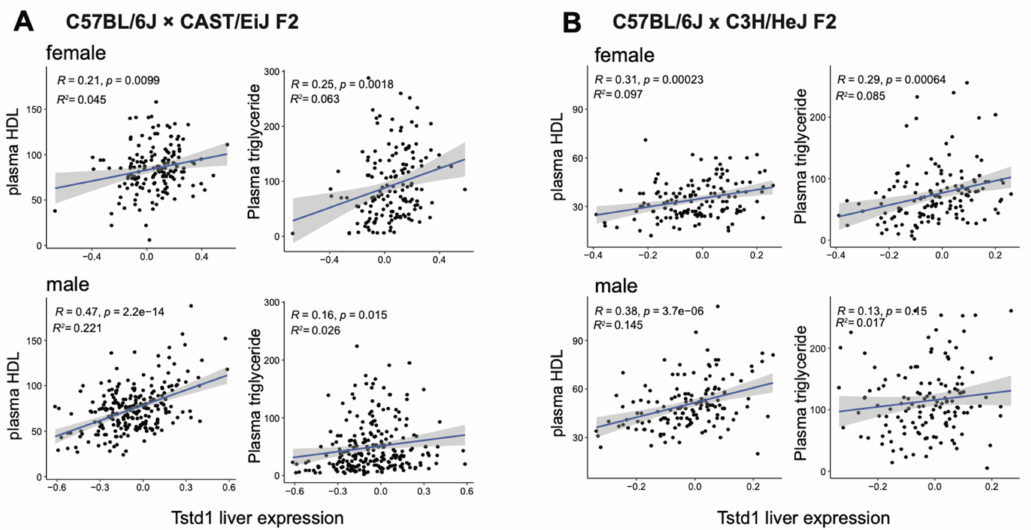
Figure 5. Validation of the link between Tstd1 and HDLs using independent mouse cohorts. Correlations between liver Tstd1 expression and plasma HDL and triglyceride levels were investigated in male and female mice from the F2 cohorts derived from C57BL/6J and CAST/EiJ ( A ) and C57BL/6J and C3H/HeJ ( B ) Pearson’s correlation coefficients and p -values were